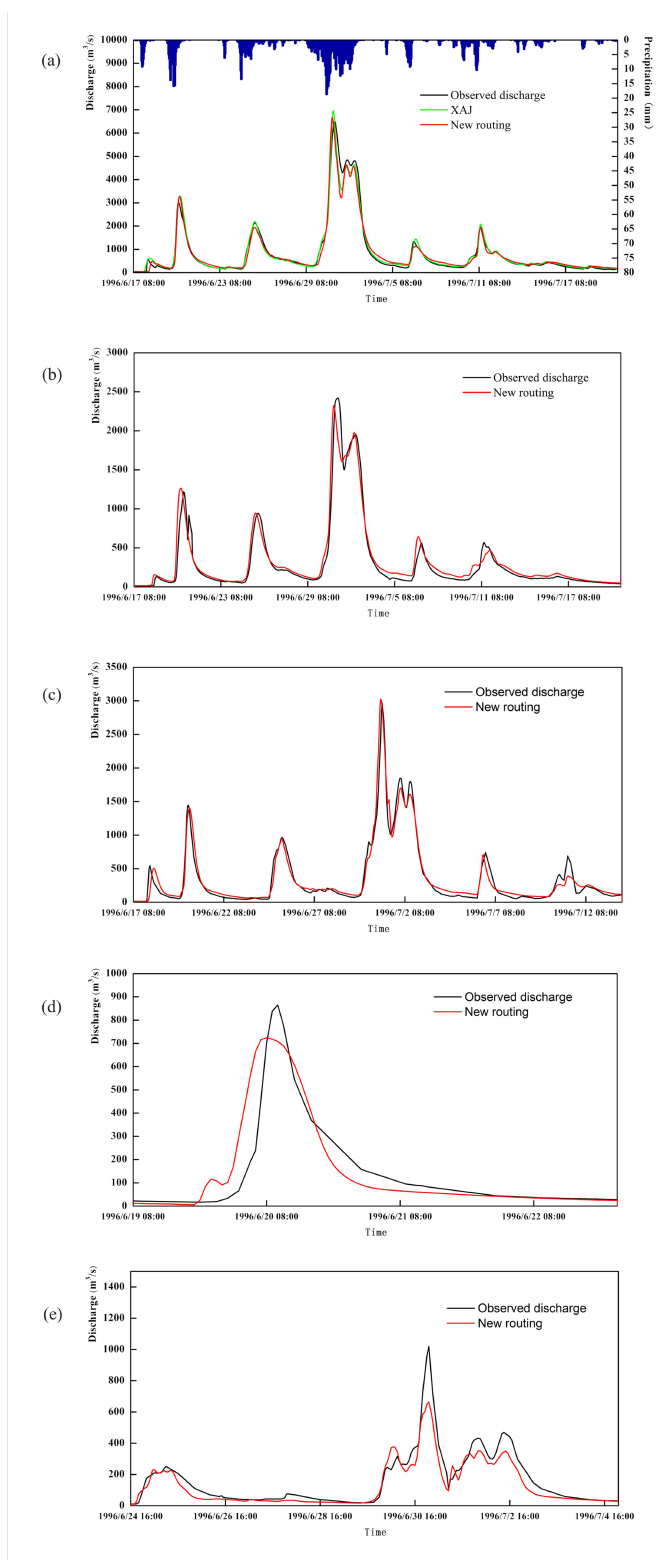
Figure 7. Examples of simulated and observed hydrographs for the Tunxi watershed by the original Xin’anjiang model (XAJ) and the improved model (new routing) at the catchment outlet ( a ) Tunxi and interior locations ( b ) Yuetan, ( c) Wanan, ( d ) Chengcun and ( e )